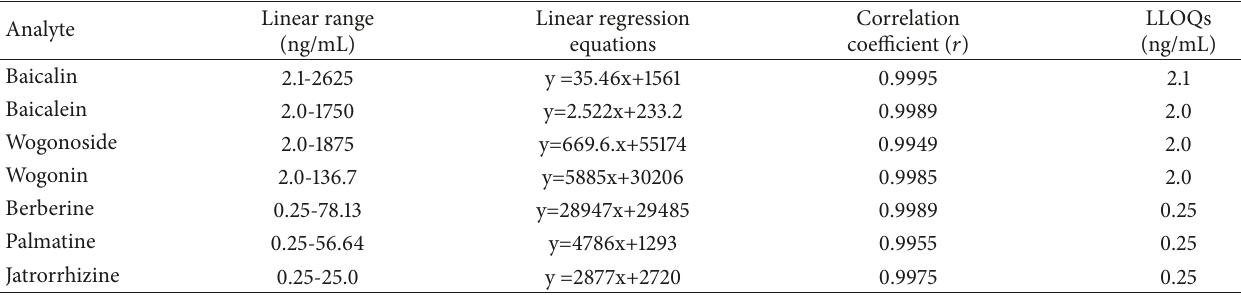
Figure 3: The concentration of seven analytes in rat plasma after oral administration of three dosages of HLJDD. Table 2: Regression data and LLOQs of the multi-components determined in